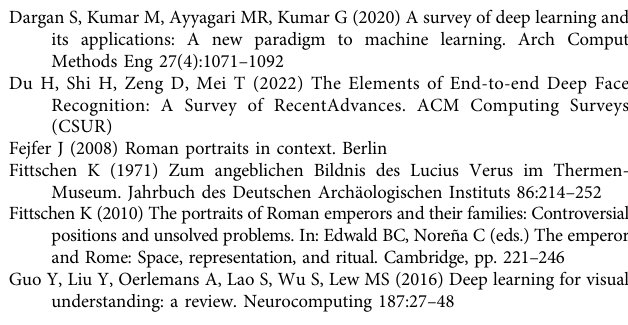
References Ando C (2000) Imperial ideology and provincial loyalty in the Roman Empire. Berkeley Buslaev A, Iglovikov VI, Khvedchenya E, Parinov A, Druzhinin M, Kalinin AA (2020) Albumentations: fast and fl exible image augmentations. Information 11(2):125. https://doi.org/10.3390/info11020125